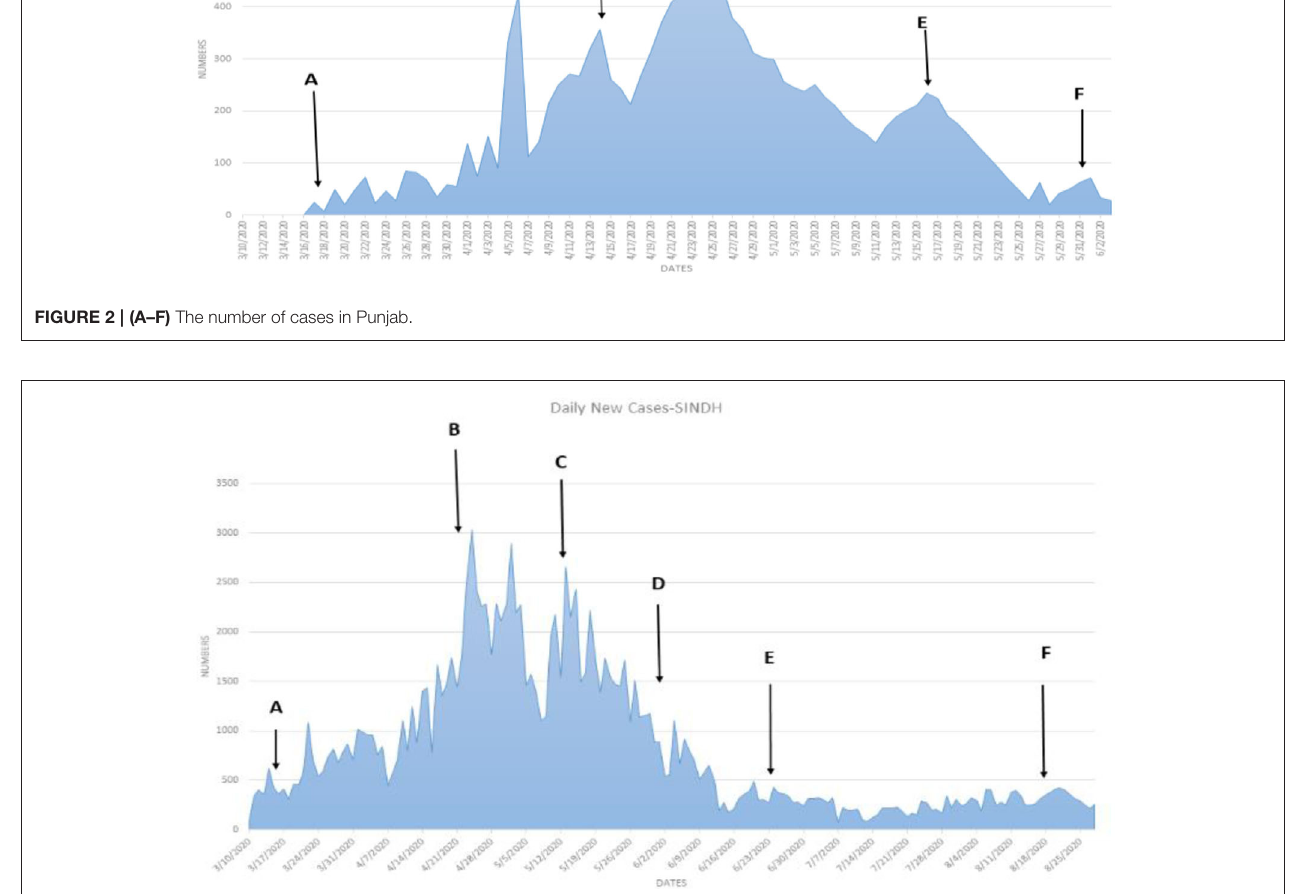
FIGURE 3 | (A–F) The number of cases in